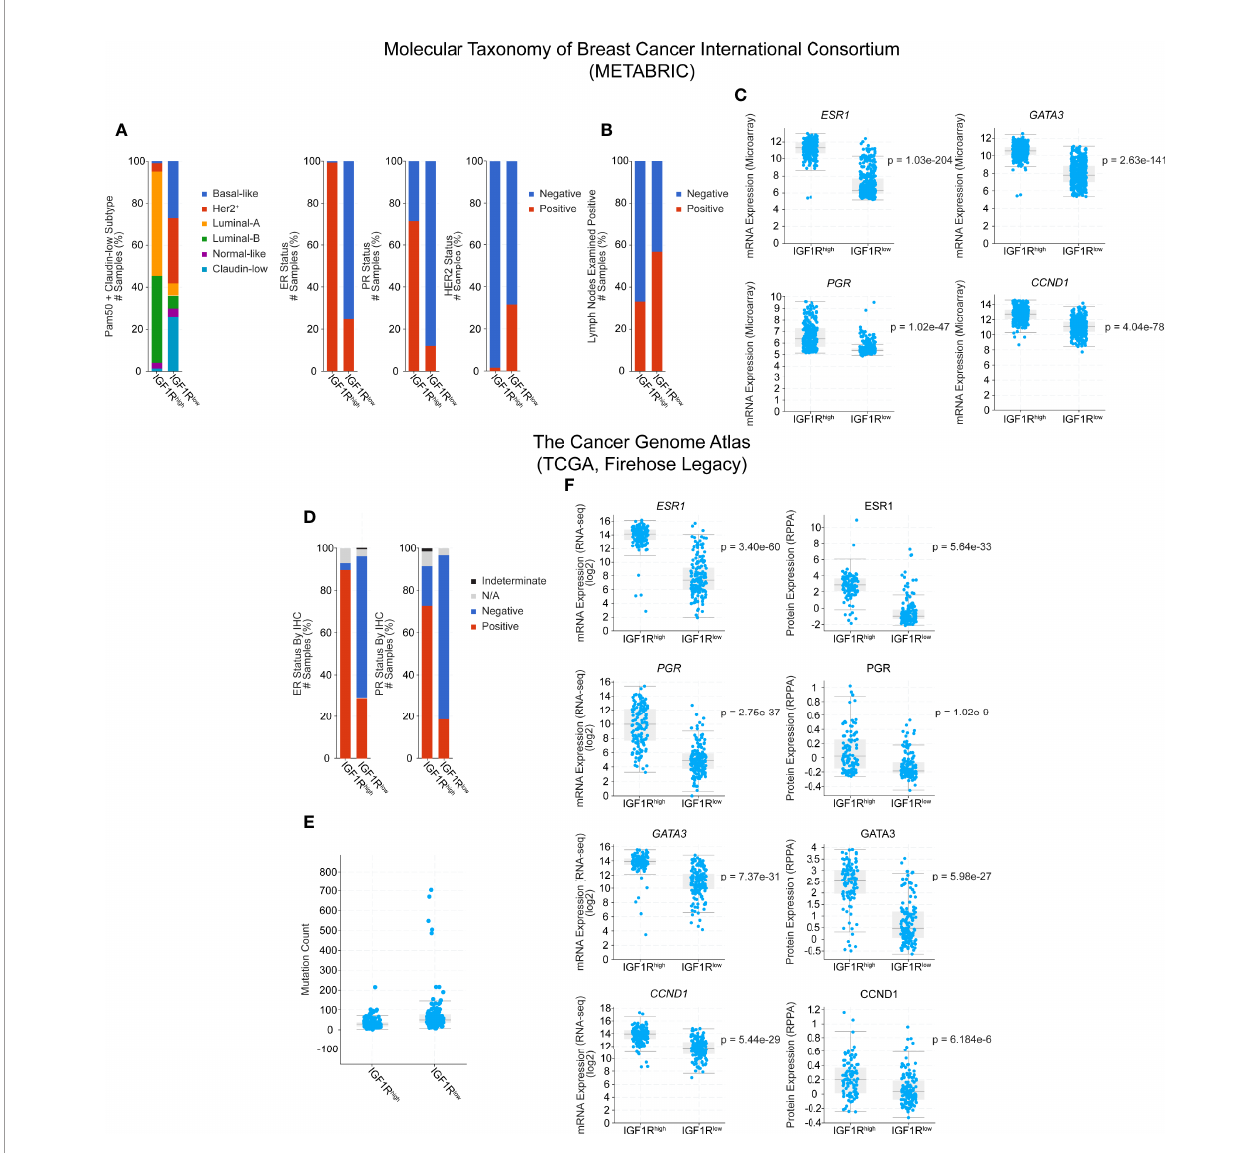
FIGURE 1 | Clinical characteristic and gene expression analysis of IGF1R high and IGF1R low human breast tumors from the Molecular Taxonomy of Breast Cancer International Consortium (METABRIC) and The Cancer Genome Atlas (TCGA) databases. Cohorts were generated by classifying patients by either high (z-score > 1, METABRIC n = 300, TCGA n = 128) or low (z-score < -1, METABRIC n = 415, TCGA n = 153) expression of IGF1R, while average patients (-1 < z-score < 1) were excluded. (A) PAM50 classi fi cation of patient tumors and hormone receptor expression status. (B) Lymph node positivity. (C) Gene expression microarray data for ESR1 , PGR , GATA3 , and CCND1 . (D) Hormone receptor status in the TCGA cohorts. (E) Mutation count. (F) Gene (left) and protein (right) expression data for ESR1 , PGR , GATA3 , and CCND1 . Statistical analyses were generated by cBioPortal and are student t-tests, where signi fi cance was de fi ned as p < 0.05. N/A, Not